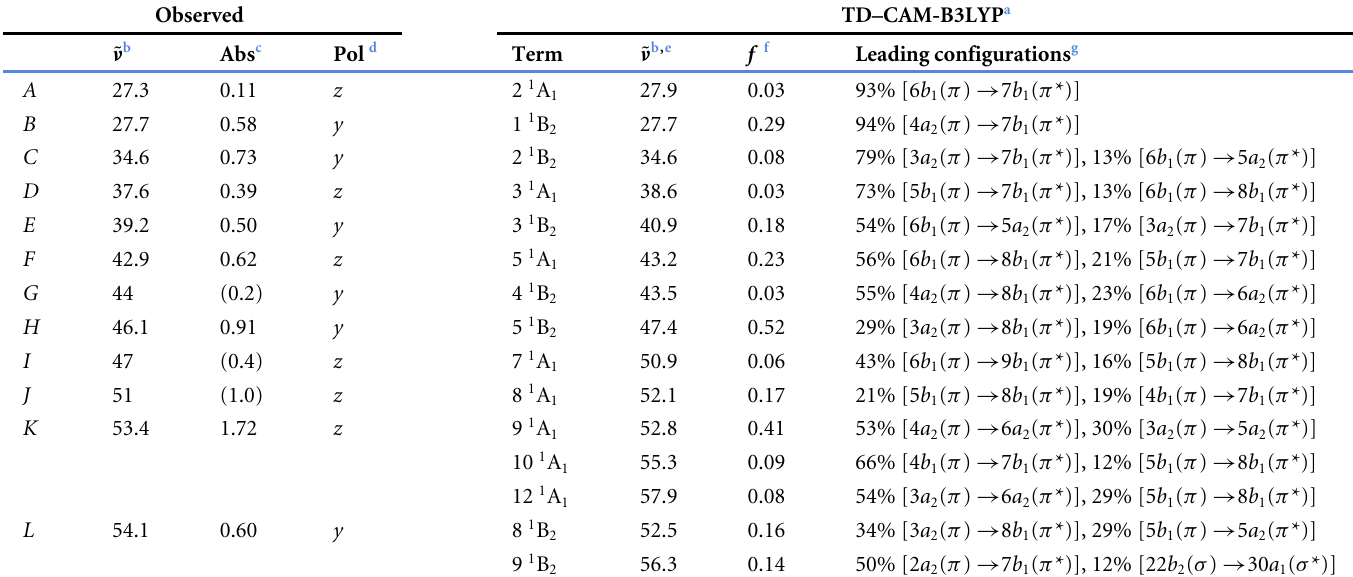
Table 1 Observed features of the SRLD spectrum of anthralin (A) and theoretical electronic transitions predicted with TD–CAM-B3LYP/aug-